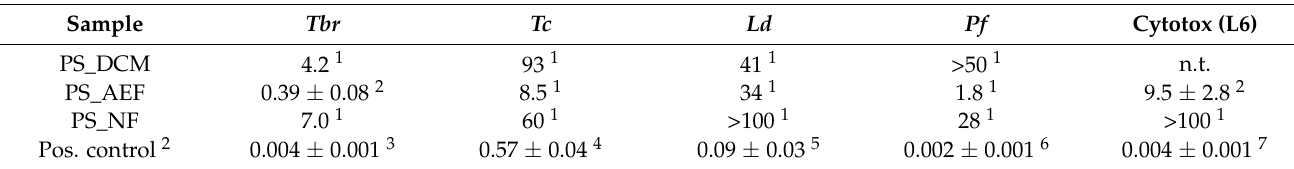
Table 1. Biological activity of P. terminalis crude dichloromethane (DCM) extract and its fractions. Data are expressed as IC 50 values in µ